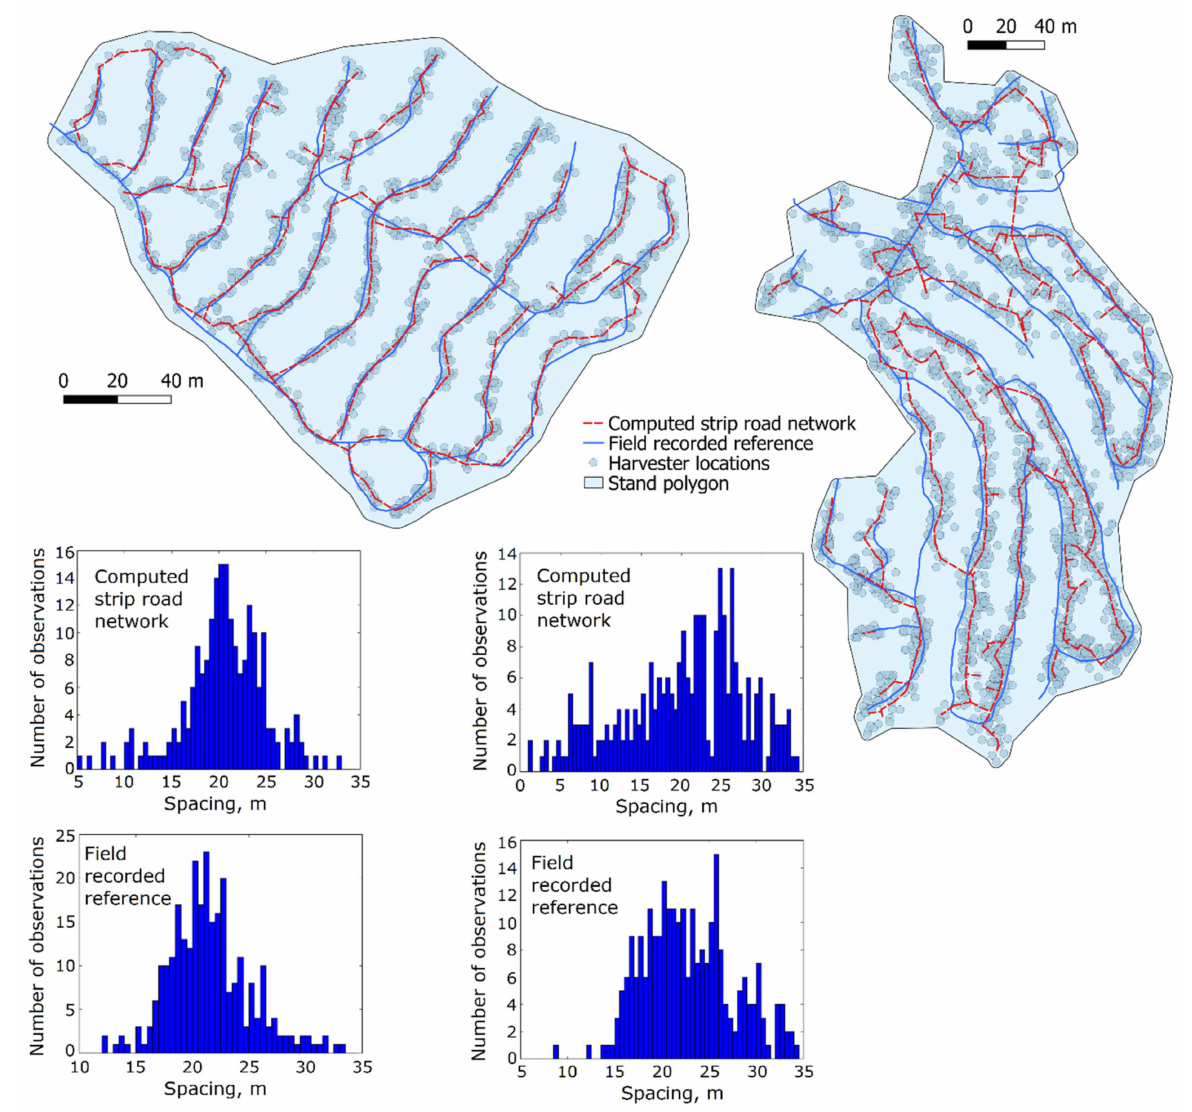
Figure 11. Two examples of reference stands. The histograms show the distributions of strip road spacing values calculated for both computed and field-recorded reference strip road networks. The average spacings are 20.6 m and 21.7 m for the stand on the left, and 20.2 m and 22.9 m for the stand one right, with reference networks having the larger averages. Note the different scales of the